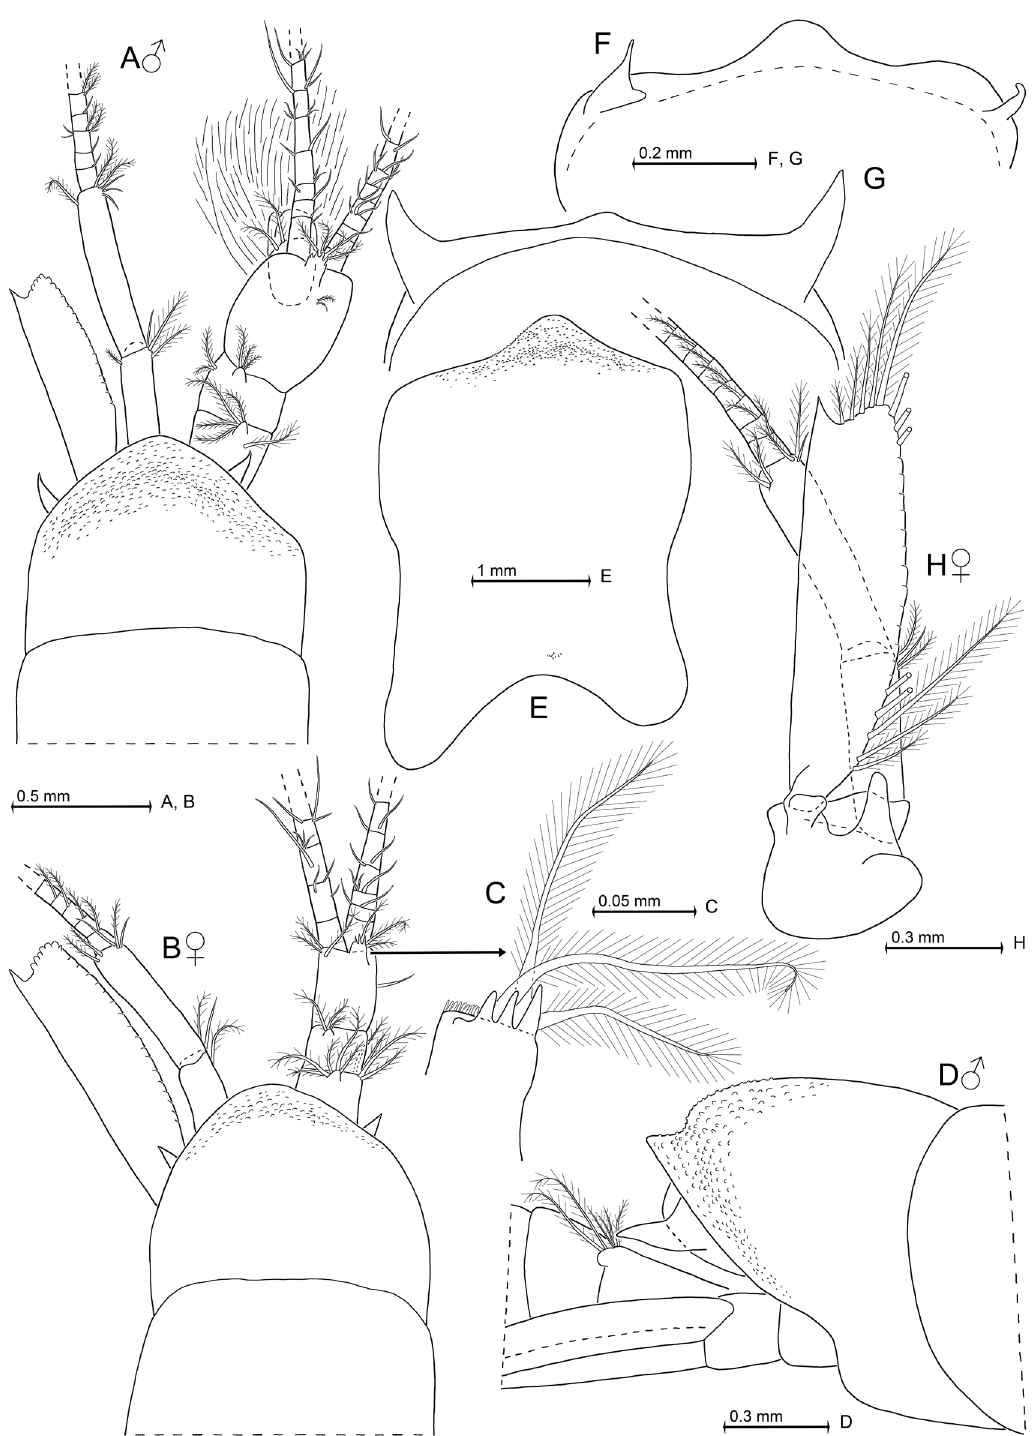
Fig. 5. Abyssomysis cornuta gen. et sp. nov., holotype, adult male with body length 6.6 mm (A: ZMH 58250), paratypes female 7.9 mm (B–C, E–F, H: ZMH 58256) and male 6.7 mm (D, G: ZMH 58254). A–B . Cephalic region of male (A) and female (B), dorsal; left antennula, right antenna and setae of antennal scale omitted. C . Detail of panel (B) showing lobe from terminal segment of antennula. D . Head in lateral view, setae of antennal scale omitted. E . Carapace expanded on slide. F–G . Eyeplate expanded on slide, for female (F) and male (G). H . Antenna,